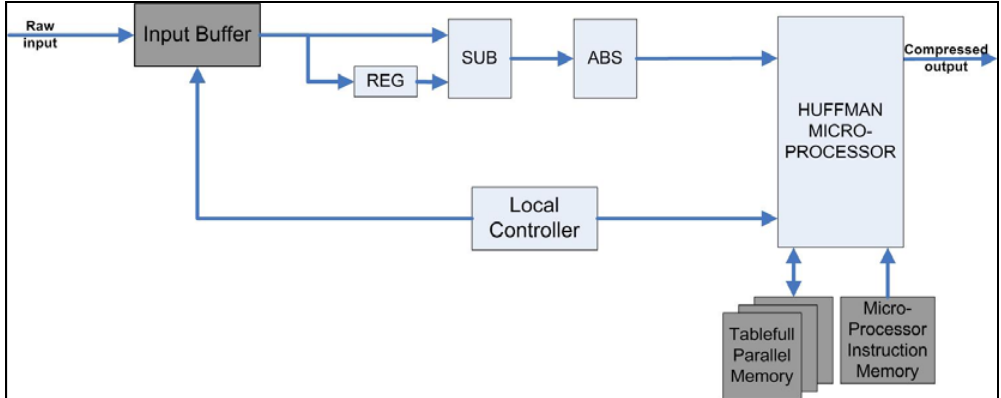
Figure 3. Compression module block diagram.